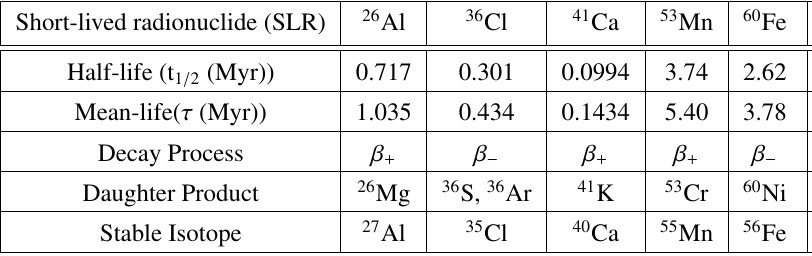
Table 1. Details of Short-Lived Radio nuclides considered in this work. The data of half-life and decay modes is taken from